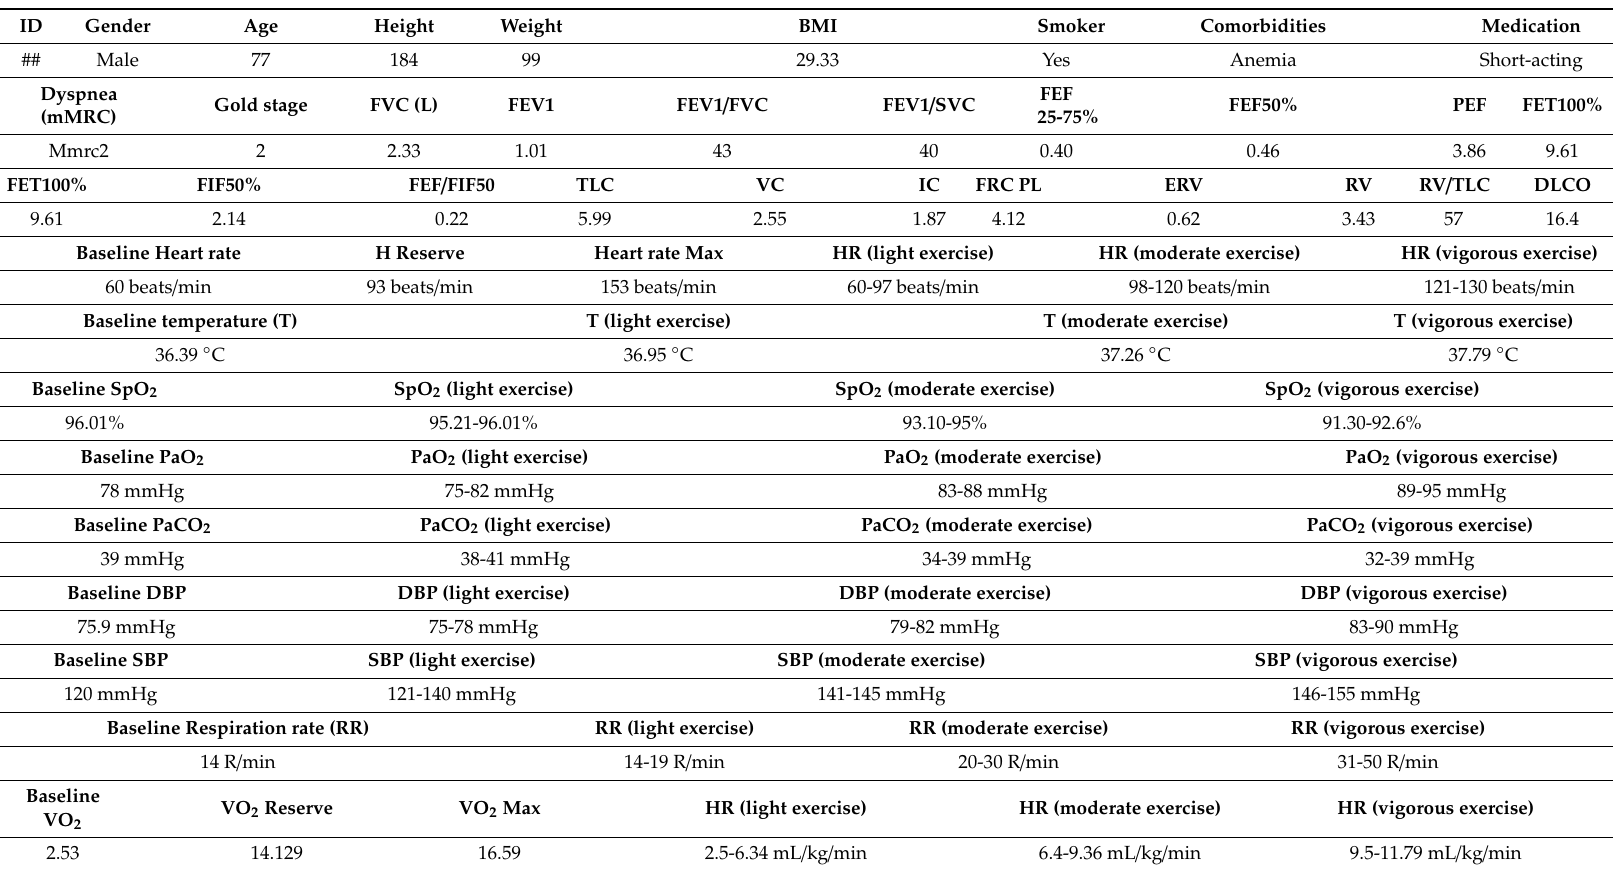
Table 6. An example of a medical